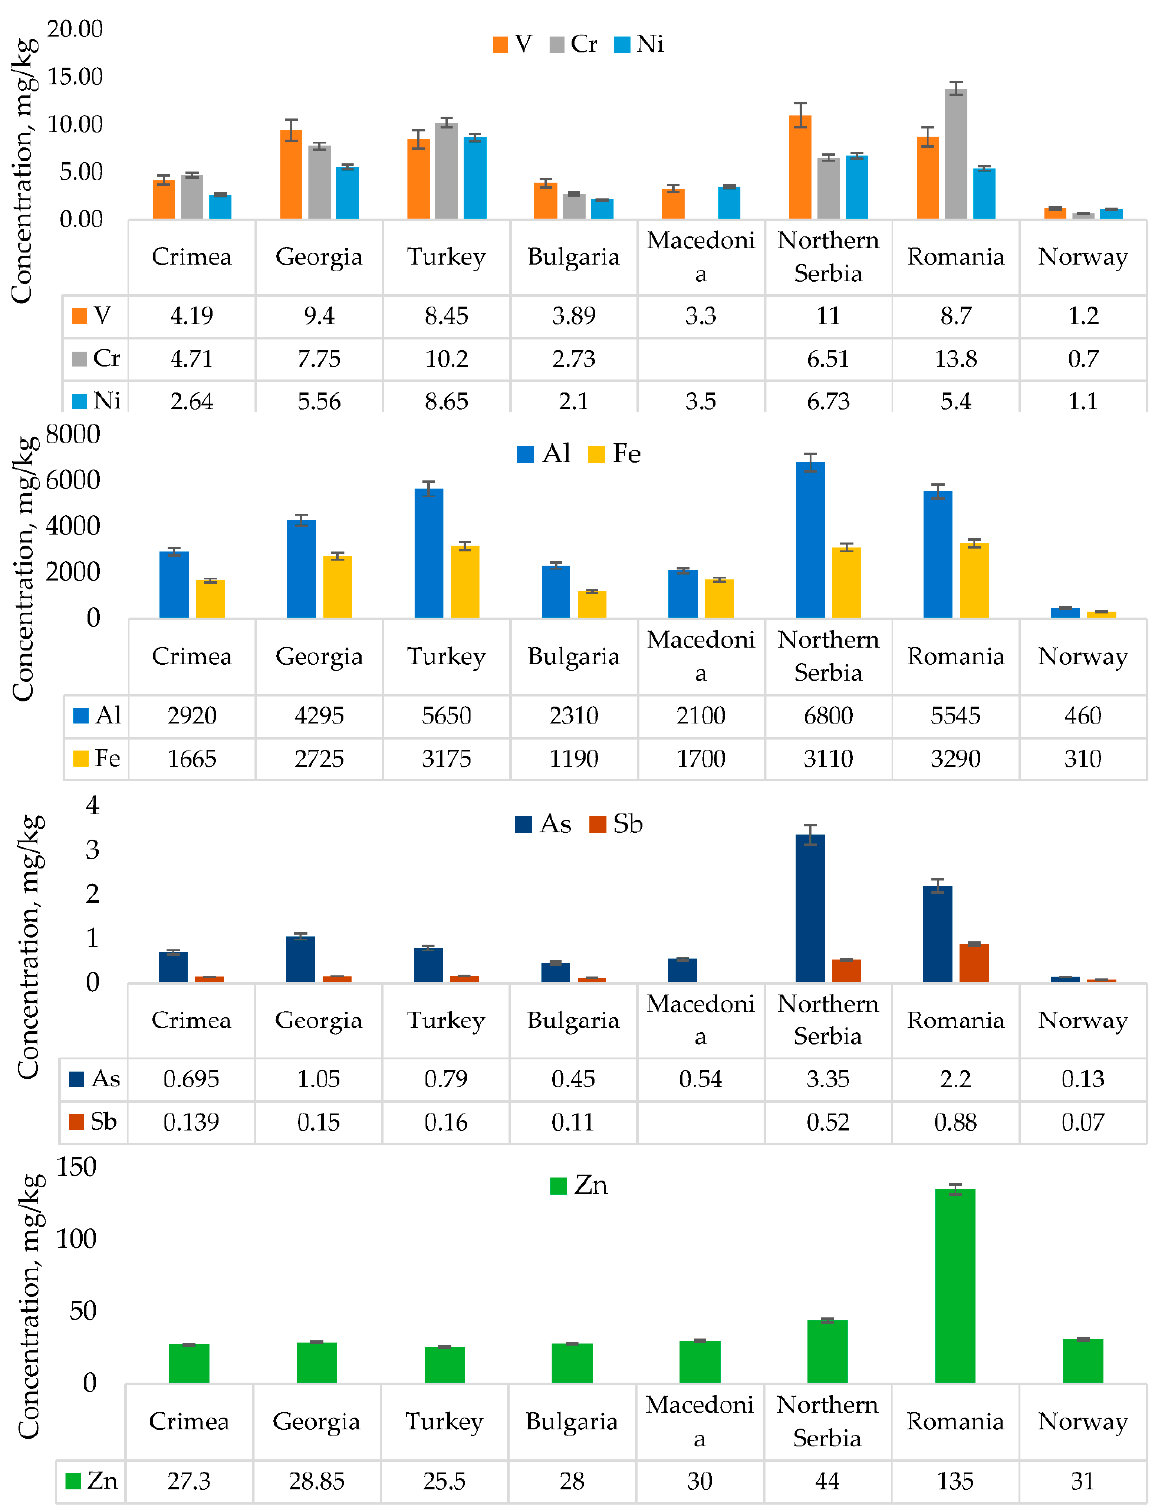
Figure 4. Comparison of the median levels of V, Cr, Ni, Al, Fe, As, and Sb (mg/kg) in mosses from Crimea (present data), Georgia [23], Turkey [32], Bulgaria [33], Macedonia [34], Northern Serbia [35], Romania [36], and Norway [37].